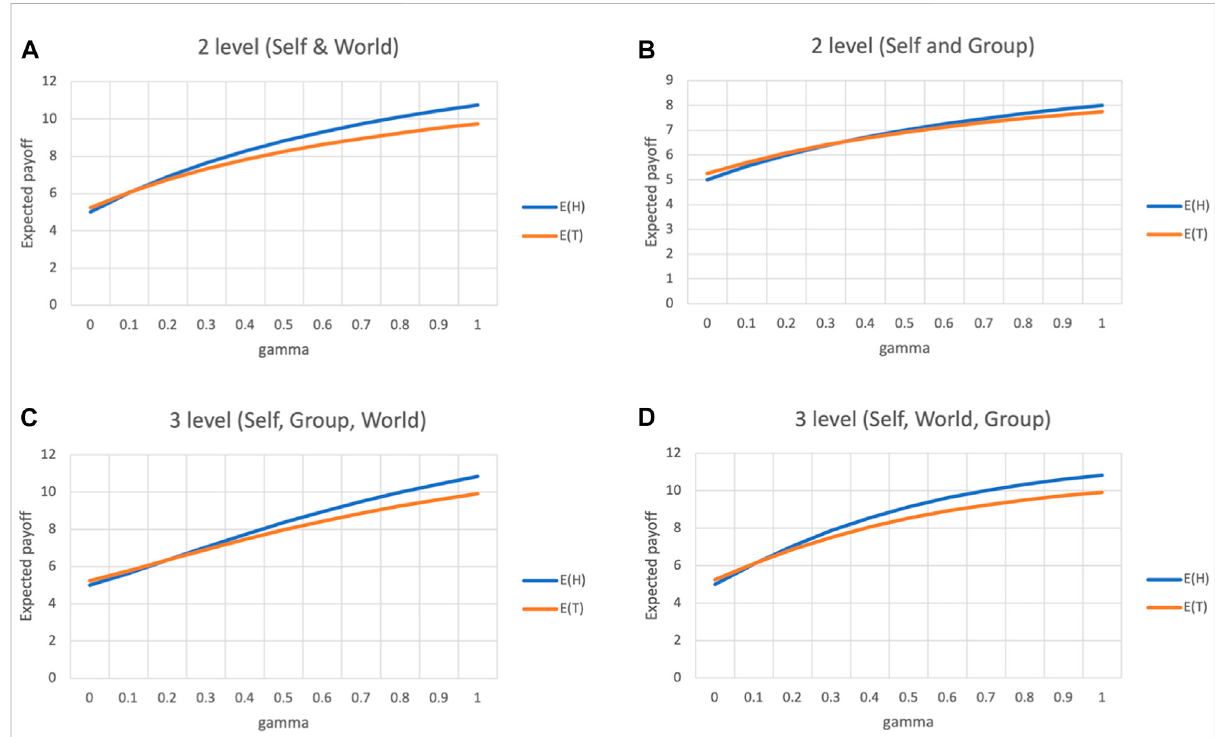
FIGURE 3 TranscendenceinathreeplayerPDgame (A) TranscendencefromSelftoWorld (B) TranscendencefromSelftoGroup (C) Transcendencefrom Self to Group ( d g = 1) to World ( d w = 2) (D) Transcendence from Self to Group ( d g = 2) to World ( d w =